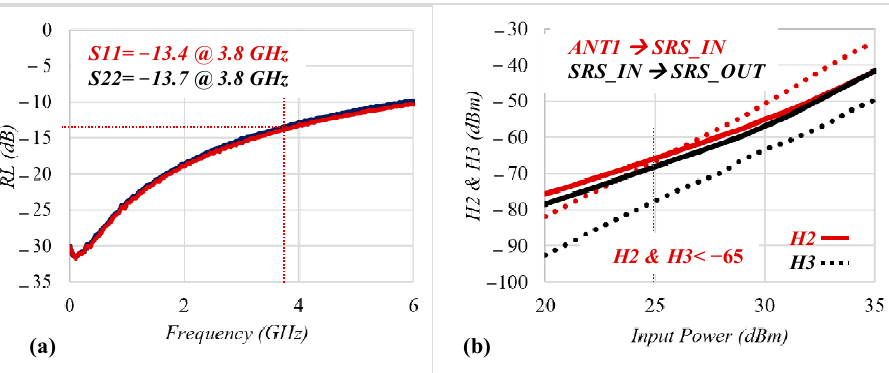
Figure 5. Measured result of the ( a ) IL and ( b ) isolation of the proposed 3P3T.